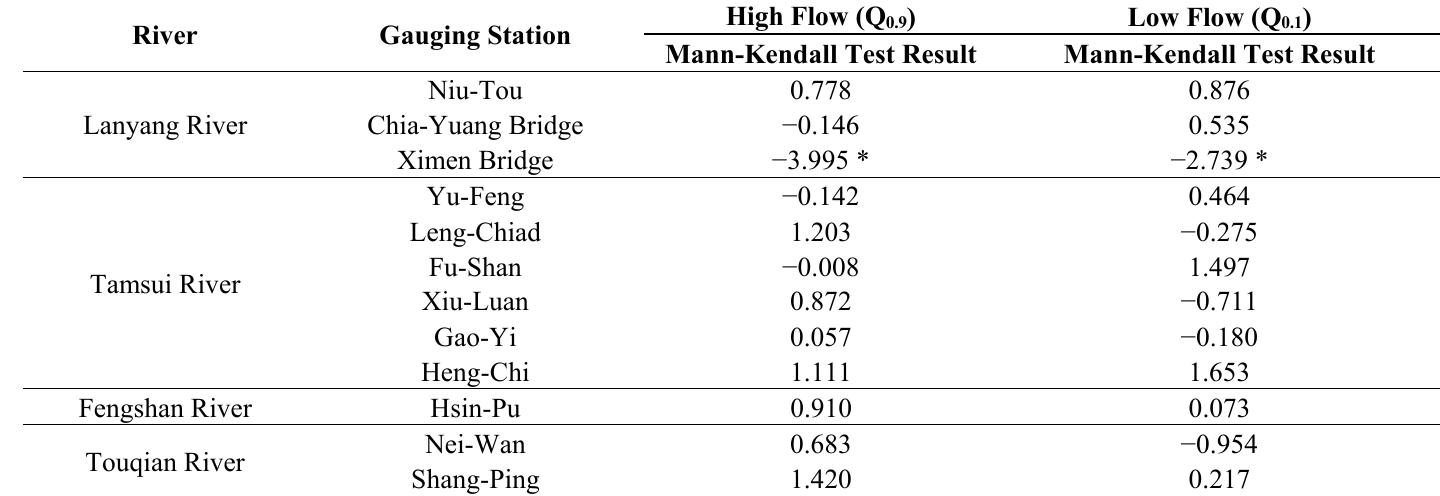
Table 7. Mann-Kentall test results for the high and low